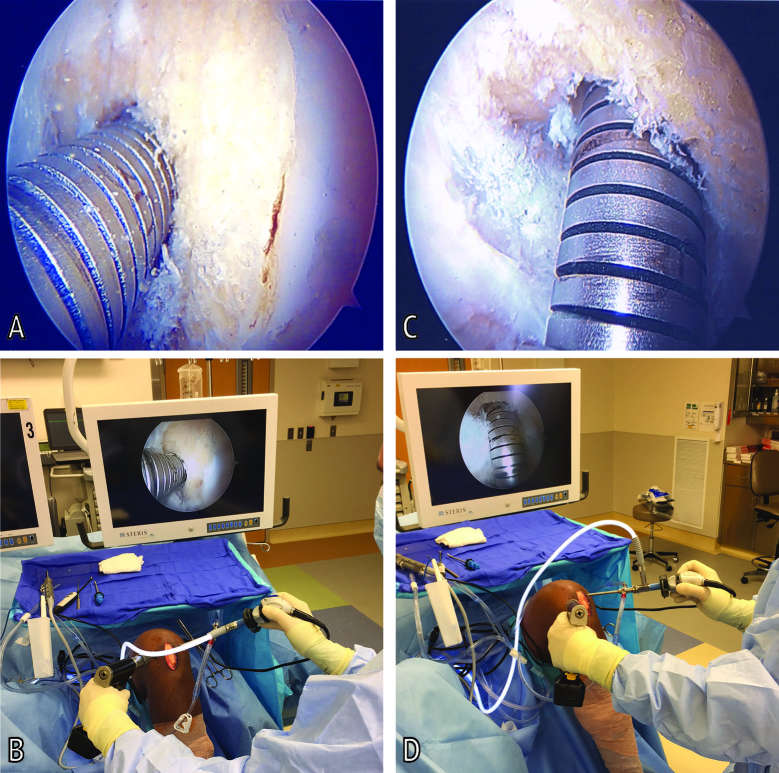
 Arthroscopic images of a left knee during femoral tunnel reaming to obtain femoral tunnel reamer measurements. (A) Standard notch view (B) Surgeon hand and camera position for obtaining standard notch view (C) Top-down view (D) Surgeon hand and camera position for obtaining top-down view.